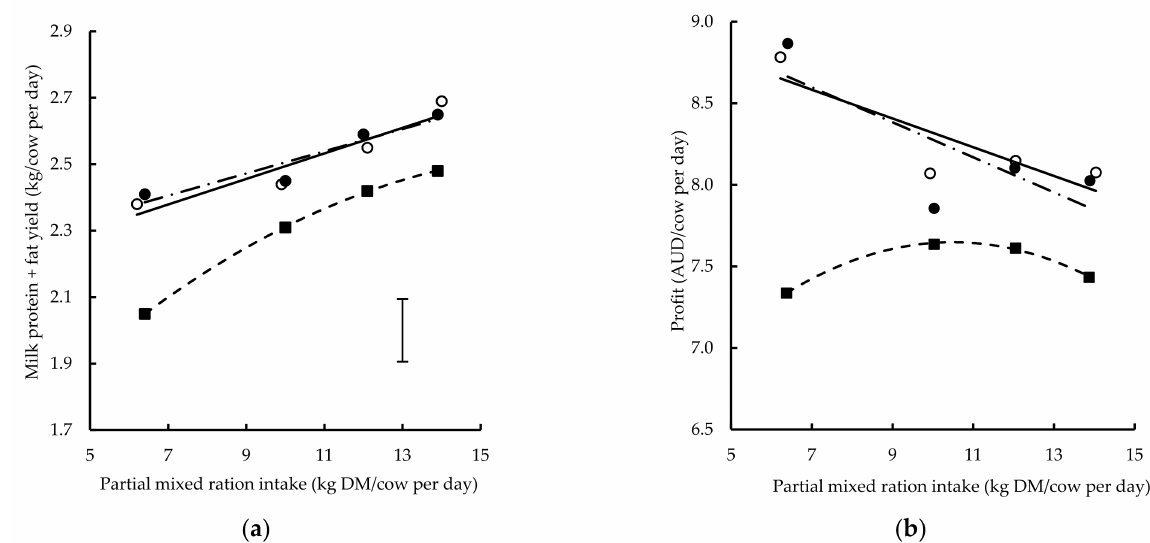
) or high ( • ). Lines represent (cid:35)